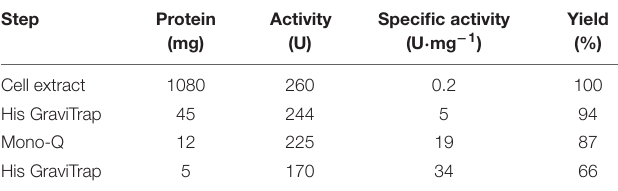
TABLE 3B | Purification of Pa 3HB6H produced in E. coli.